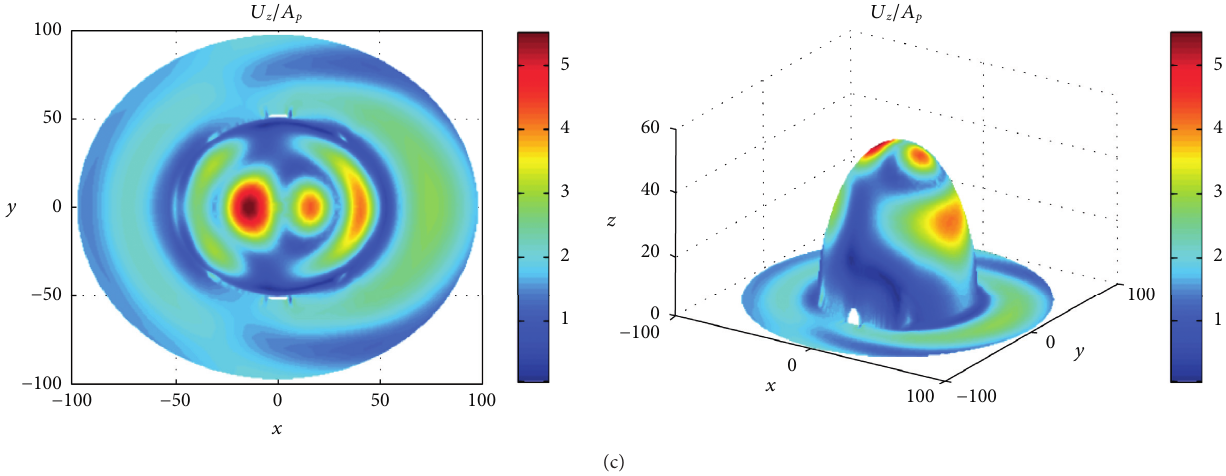
Figure 9: Surface displacement amplitude of the 3D tunnel mountain under the incident P wave ( η � 2 . 0 , α � 30 ° ): (a) surface displacement amplitude in x direction; (b) surface displacement amplitude in y direction; (c) surface displacement amplitude in z direction.